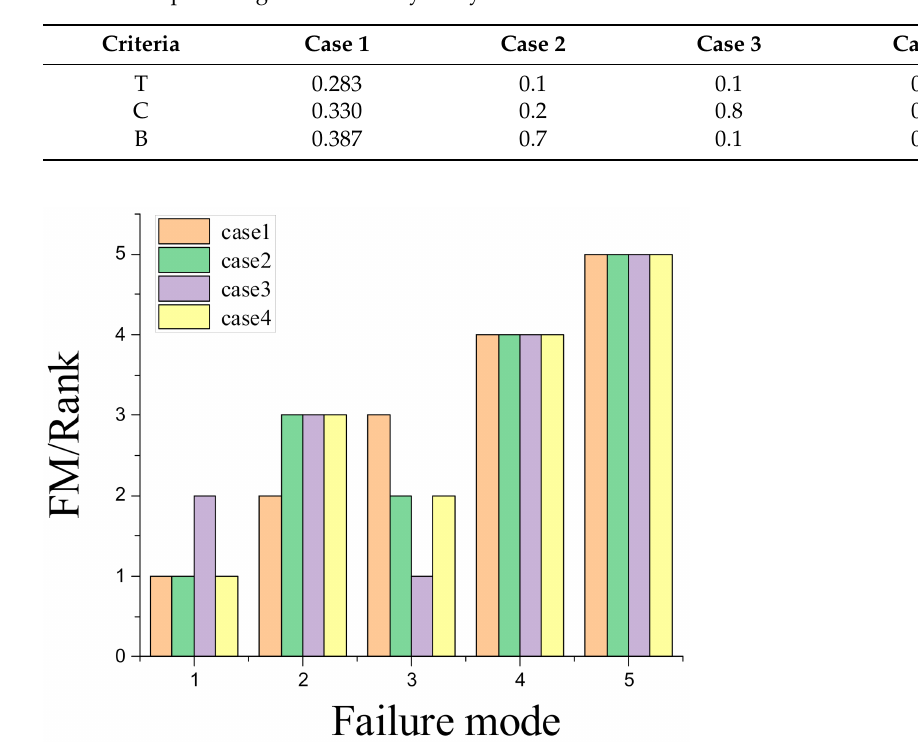
Table 8. The percentages of sensitivity analysis cases.